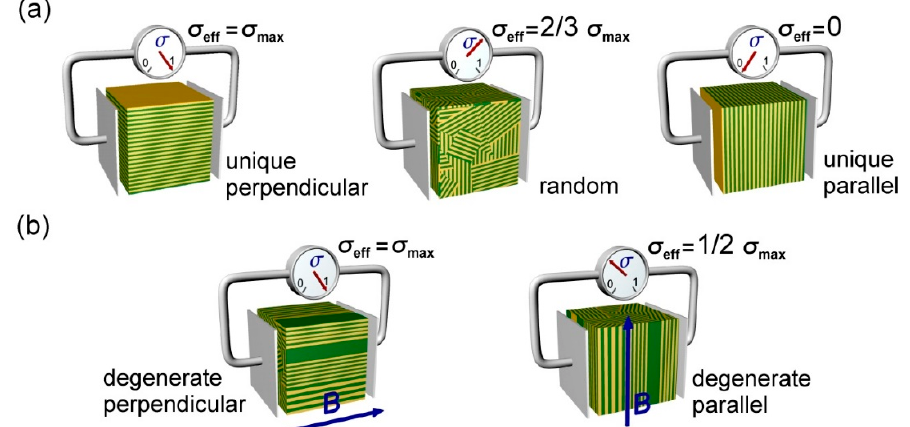
Figure 1. Ionic conductivity in a lamellar diblock copolymer system. ( a ) Limiting cases of lamellar alignment and orientation with respect to electrode surfaces lead to normalized e ff ective conductivities that are maximum ( σ ef f = 1), random distribution averaged (2 / 3), and zero conductivity. ( b ) Degenerate alignments yield maximum ( σ ef f = 1) and weighted average ( σ ef f = 1/2)